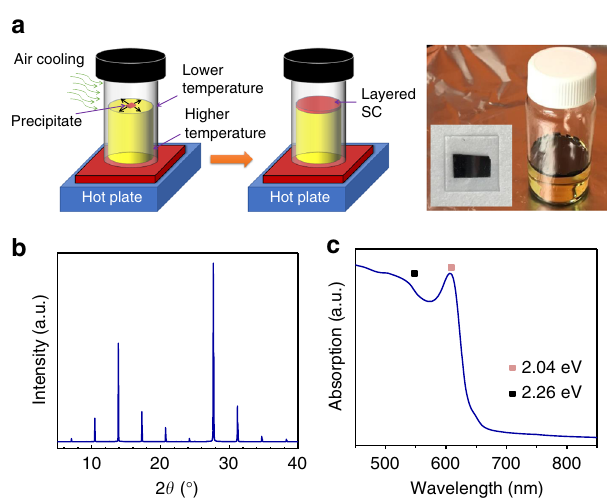
Fig. 2 Layered perovskite single crystals synthesis and characterization. a (left panel) Schematic of (BA) 2 (MA) 2 Pb 3 I 10 single crystal plate growth method; (right panel) photograph of (BA) 2 (MA) 2 Pb 3 I 10 single crystal platelet fl oating on the solution surfaces in a glass vial (the vial diameter is 25 mm), and the hand-cut rectangular single crystal platelet stick to a glass substrate (15 mm × 15 mm). X-ray diffraction (XRD) pattern ( b ) and absorption spectra ( c ) of (BA) 2 (MA) 2 Pb 3 I 10 single crystal (the pink dot indicates the main exciton peak and the black dot indicates the position of the band-to-band absorption edge)